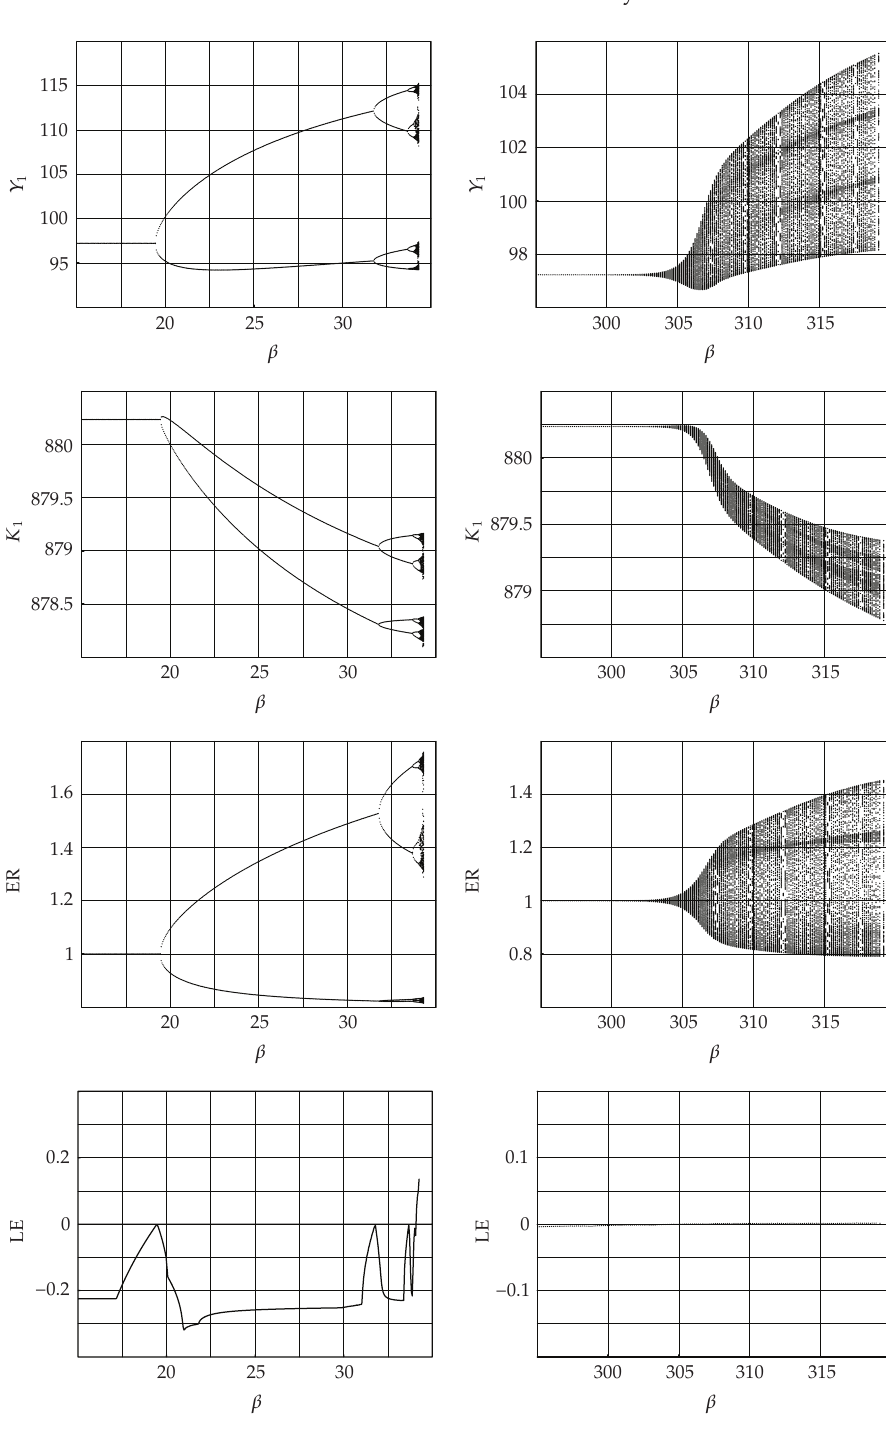
Figure 14: Left: Period doubling process for Z (cid:9) 35, δ (cid:9) 0 . 4, α (cid:9) 1 . Right: Cycles occurring for Z (cid:9) 35, δ (cid:9) 0 . 7, α (cid:9) 0 . 2